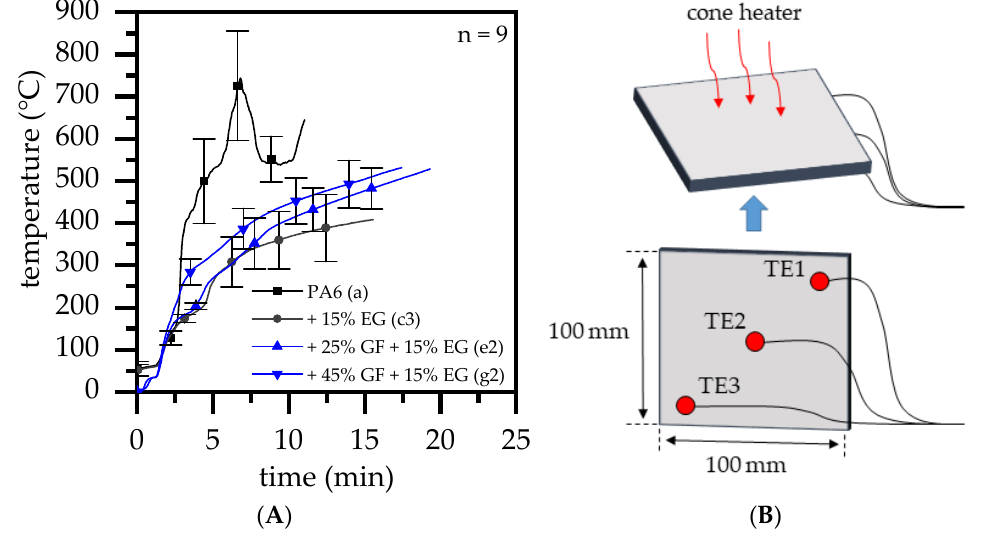
Figure 6. ( A ) Temperature measurements at the lower sample side during cone calorimeter testing in order to identify thermal insulation properties of non-reinforced and reinforced formulations. ( B ) Illustration of thermocouple positioning.